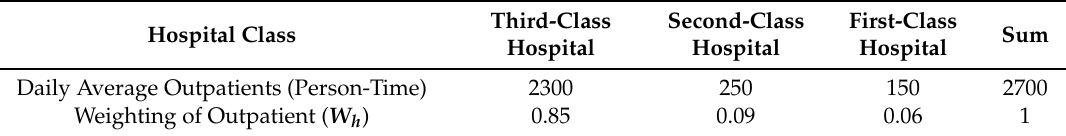
Table 4. Daily outpatient population and weighting in Wuhan.